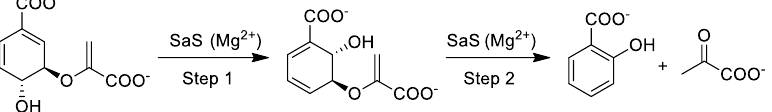
Figure 1. Scheme highlighting the reactions catalyzed by SaS in mycobacteria. In the first step, chorismate is converted to isochorismate, which is then transformed to salicylate, with the release of pyruvate.